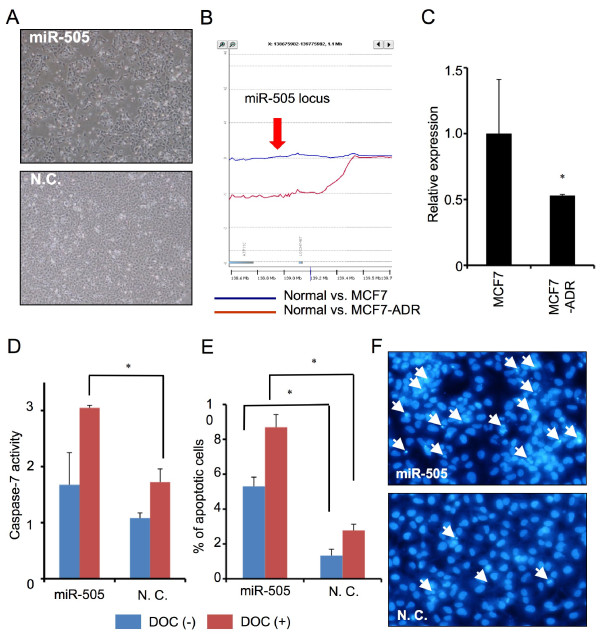
miR-505 inhibits cell growth by inducing apoptotic cell death in MCF7-ADR. (A) Images show typical MCF7-ADR cells transfected with miR-505 (top) and control miRNA (bottom) in 72 hours. (B) DNA copy number on the miR-505 locus of MCF7-ADR deleted as compared with that of MCF7. (C) Real-time RT-PCR analysis was performed to determine expression levels of miR-505 in parental cell line MCF7 and drug-resistant cell line MCF7-ADR. Error bar represents S.D. of triplicate determinations in a single experiment. P < 0.05. (D). Seventy-two hours after transfection, caspase-7 activity in the presence or absence of DOC (1 nM) was detected in miR-505 or control miRNA-transfected MCF7-ADR cells. n = 6, P < 0.001. (E) Condensed and fragmented apoptotic cells are counted in the presence or absence of DOC (1 nM) by staining with Hoechst dye. n = 4, P < 0.05. Mean ± S.D. is shown. (F) Images of apoptotic nuclear condensation and fragmentation. Seventy-two hours after transfection with miR-505 (top) or control miRNA (bottom), condensed and fragmented cells are observed. White arrows show apoptotic cells in culture.